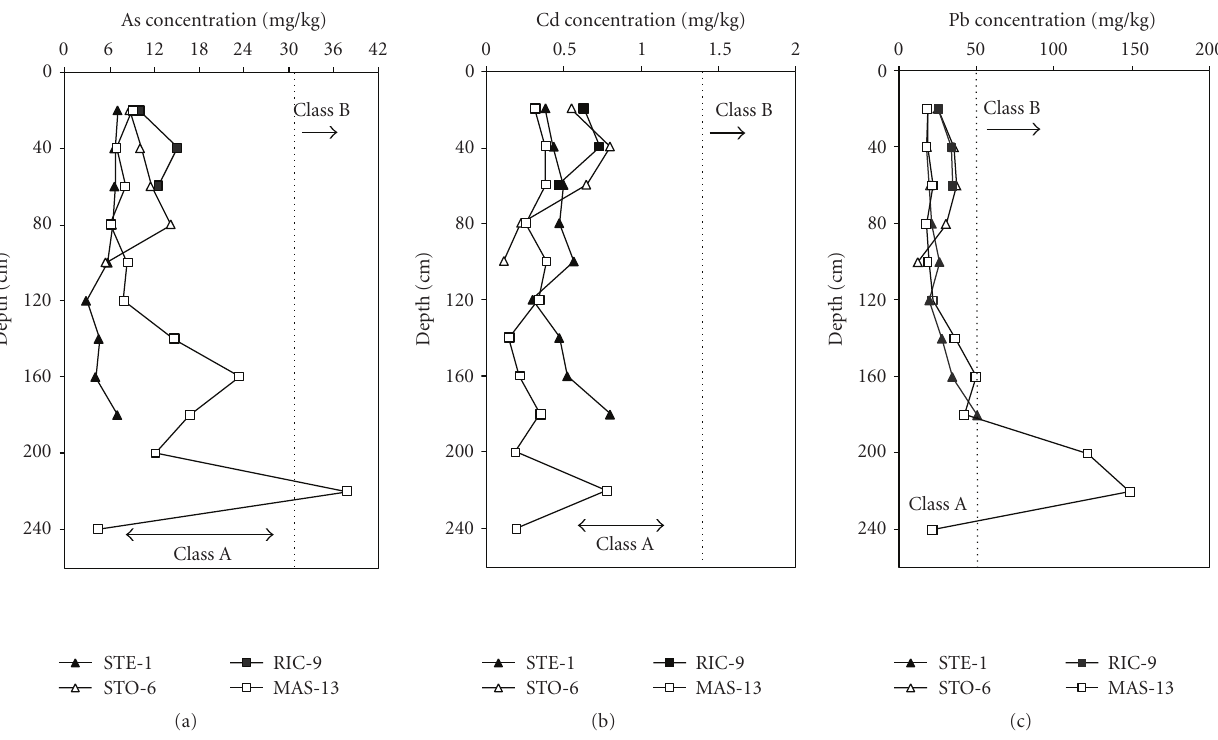
Figure 3: As, Cd and Pb concentrations in selected soil profiles (STE-1, STO-6, RIC-9 and MAS-13). The dotted line delimits classes A and B of soil contamination based on the MDDEP criterion [19].